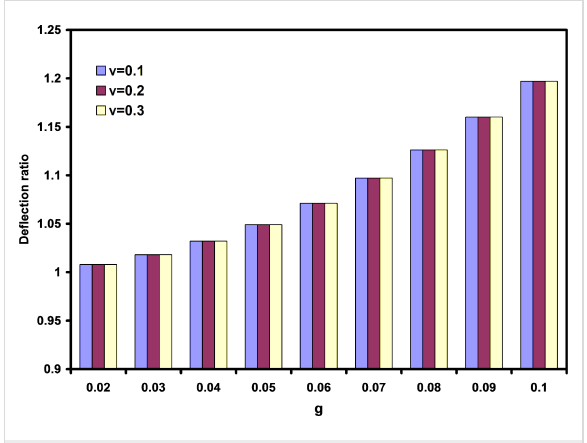
Figure 7: The effects of nonlocal parameter and Poisson's ratio on the deflection ratios.